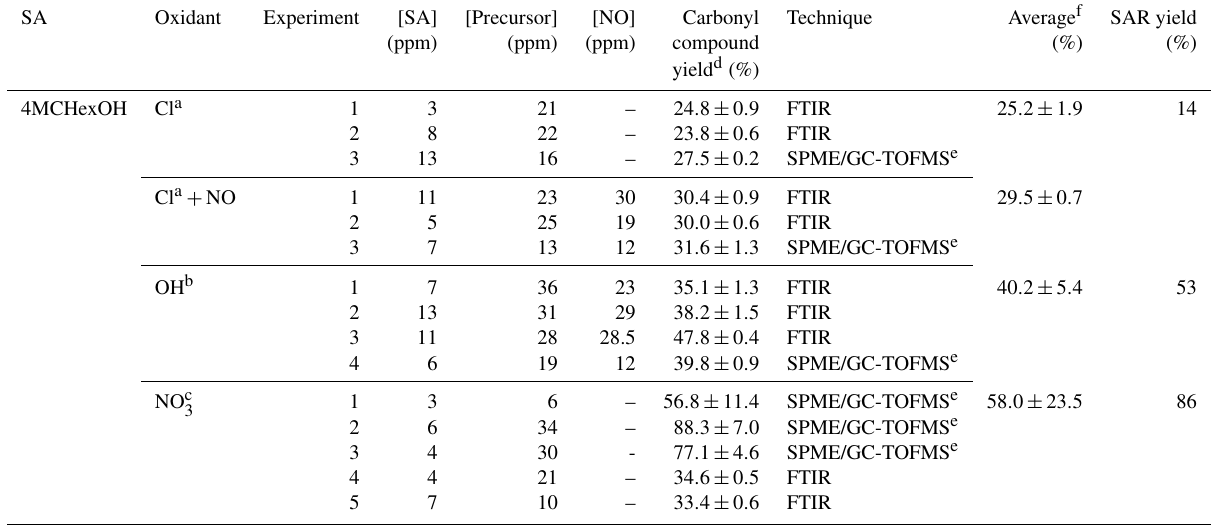
Table 3. Experimental conditions and molecular yields of (E)-4-methylcyclohexanone for the reaction of 4MCHexOH with atmospheric oxidants. SA Oxidant